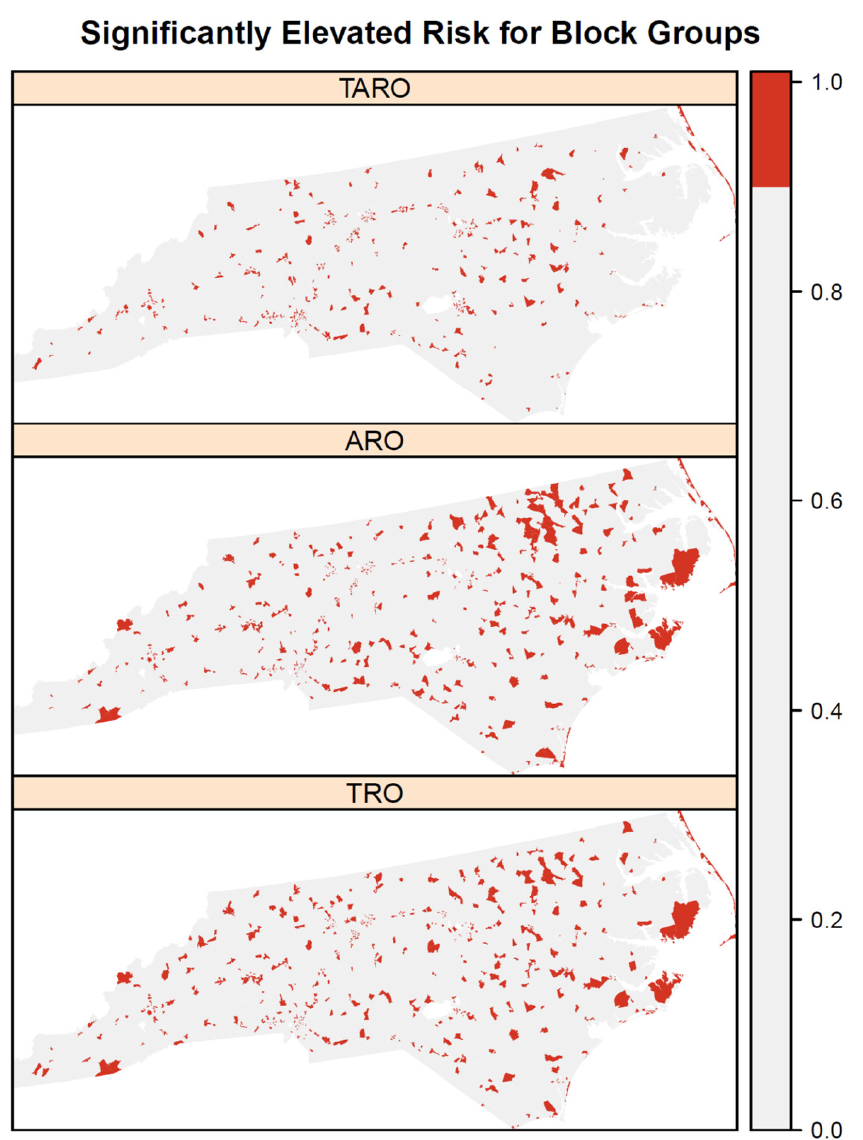
Figure 2. Block groups with significantly elevated relative risk for tobacco retail outlet (TRO), alcohol retail outlet (ARO), and tobacco and alcohol retail outlet (TARO) based on exceedance probabilities.